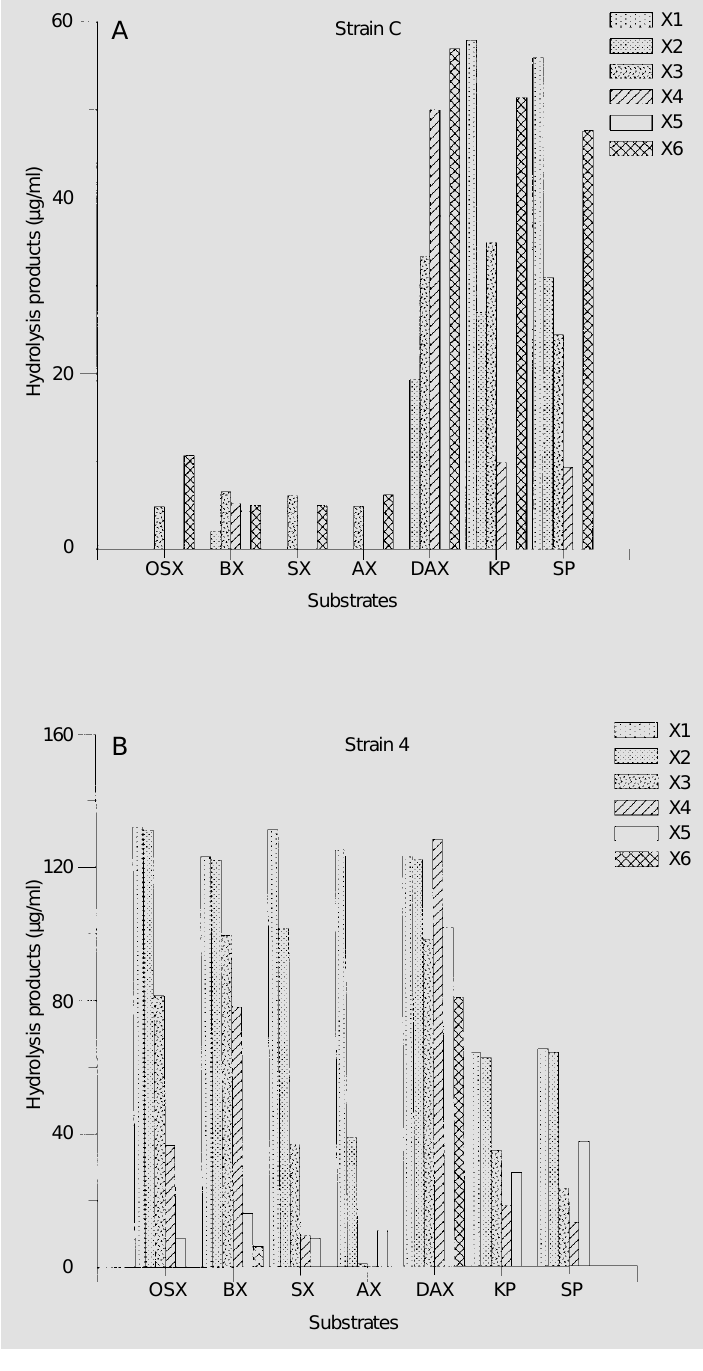
Figure 1 - Hydrolysis products of xylans and paper pulps by xylanase activity from the ultrafiltrate of Trichoderma harzianum strain C (A) and strain 4 (B). X1, Xylose; X2, xylobiose; X3, xylotriose; X4, xylotetraose; X5, xylopentaose; X6, xylohexaose; OSX, oat spelt xylan; BX, birchwood xylan; SX, seaweed xylan; AX, acetylated xylan; DAX, deacetylated xylan; KP, kraft pulp; SP, sulfite pulp. Assay conditions were given in the